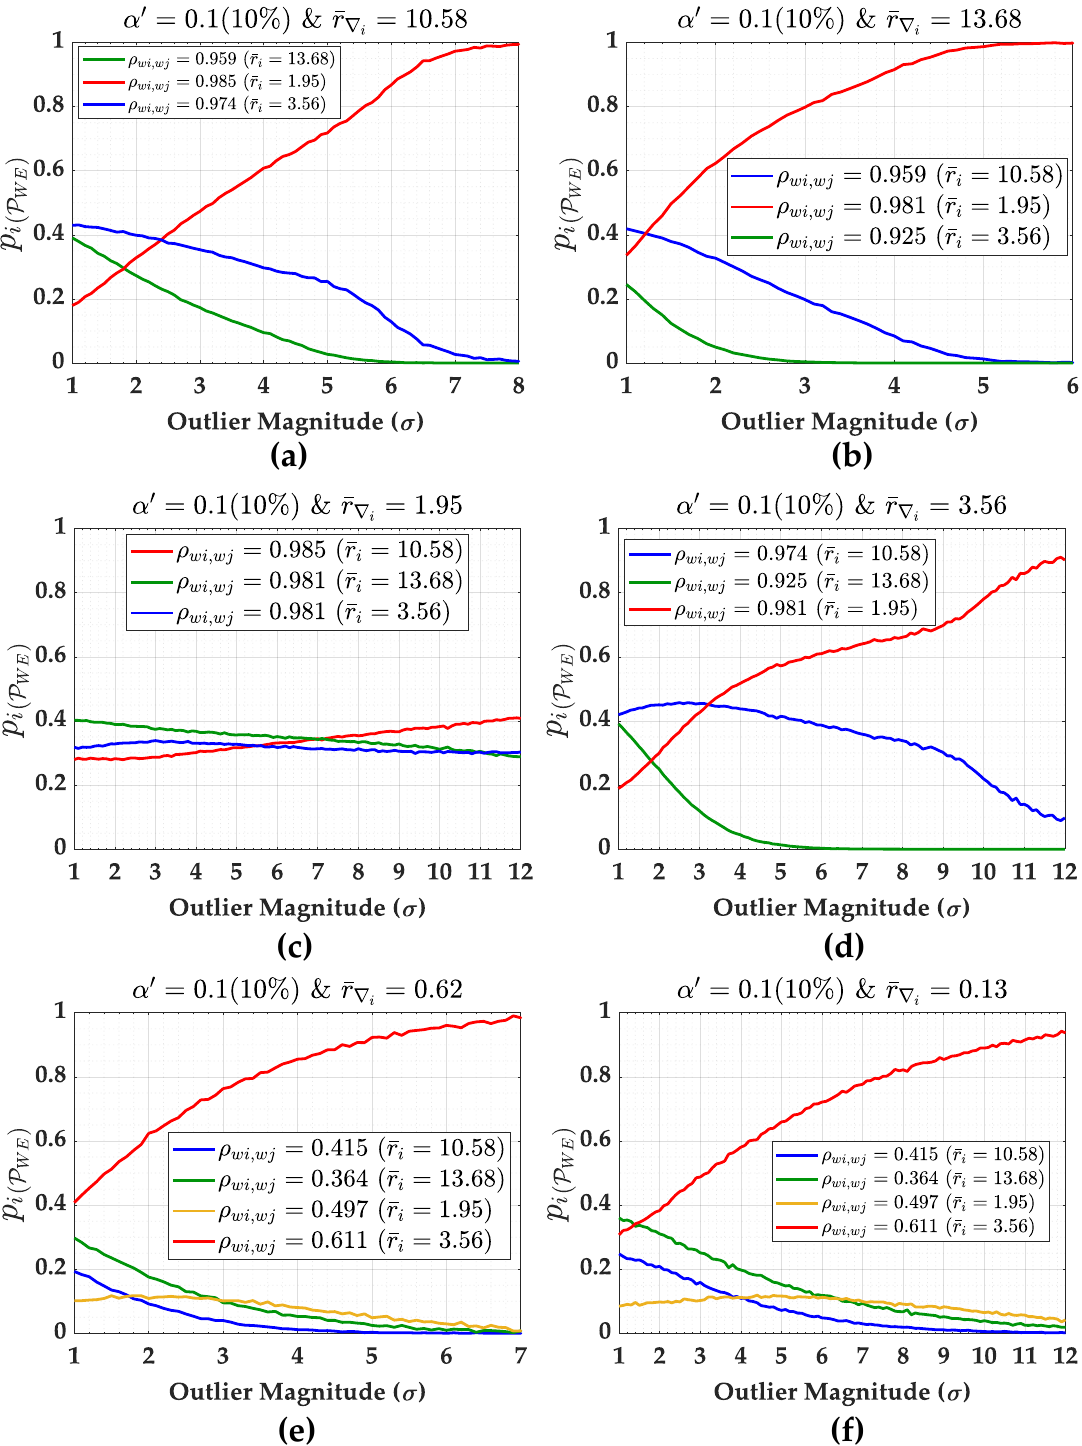
Figure 19. Weighting factors ( p i ( P ) of each measurement’s contribution to the overall wrong WE ) exclusion probability ( P WE ) for network ( b ) and for α (cid:48) = 0.1. ( a ) Weighting factors of contributions to P WE for ∆ h 1 . ( b ) Weighting factors of contributions to P WE for ∆ h 4 . ( c ) Weighting factors of contributions to P WE for ∆ h 5 . ( d ) Weighting factors of contributions to P WE for ∆ h 6 . ( e ) Weighting factors of contributions to P WE for ∆ h 2 . ( f ) Weighting factors of contributions to P WE for ∆ h 3